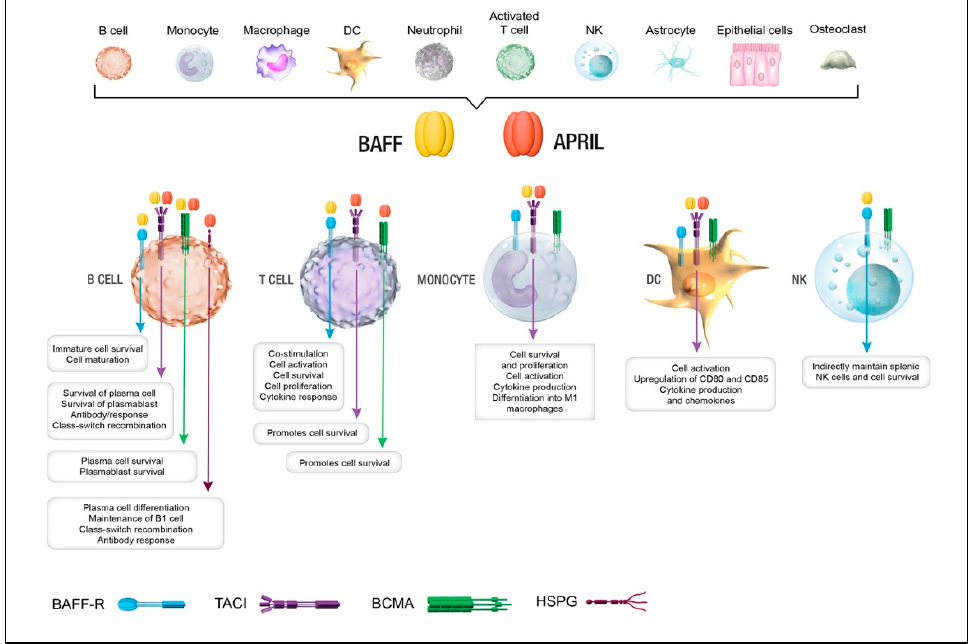
Figure 1. Effects of BAFF and APRIL on immune homeostasis. BAFF and APRIL are produced by immune and non ‐ immune cells; however, the expression of the cognate receptors is restricted to specific immune cells. BAFF ‐ APRIL binding with their corresponding receptors regulates cell differentiation, proliferation, survival, and effector functions.